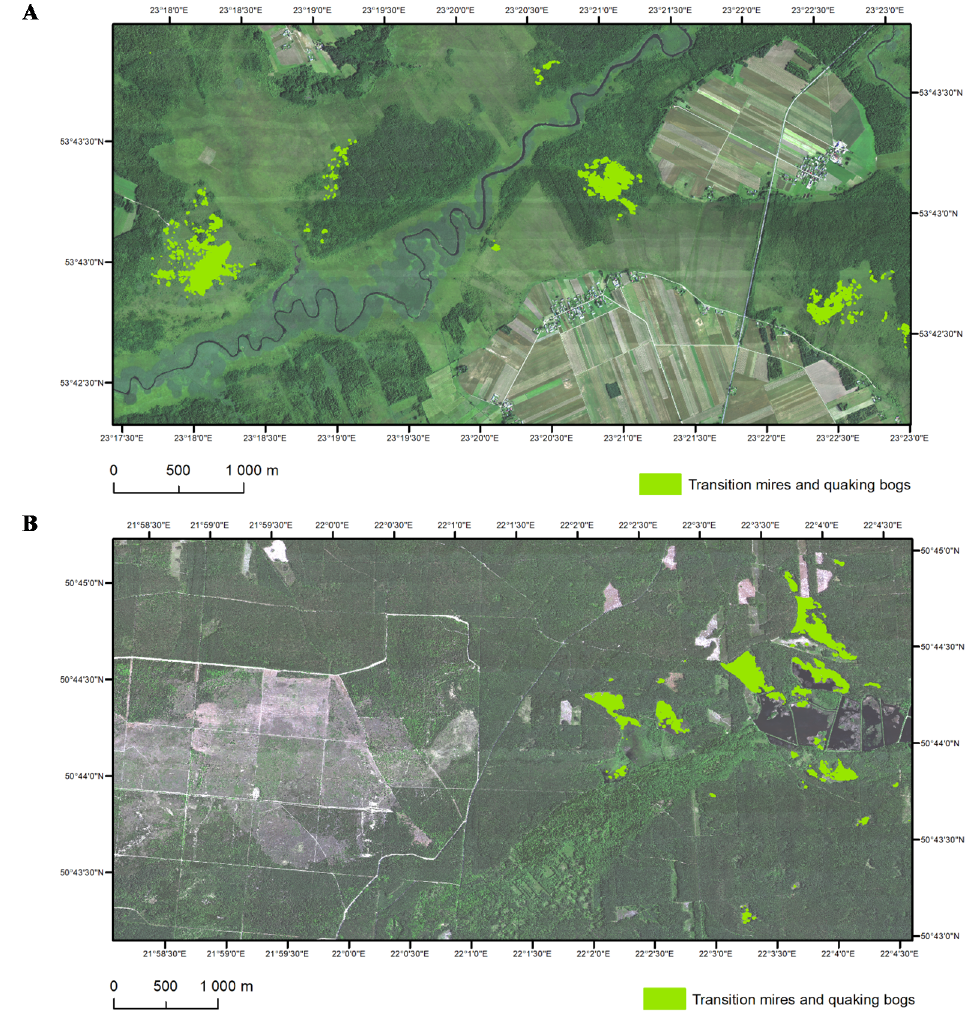
Figure 14. Distribution maps of transition mires and quaking bogs obtained from the best classification results performed on chosen sub-products in the Biebrza River Valley (( A ): Upper Biebrza—UB) and Uroczyska Lasów Janowskich—JF ( B ).